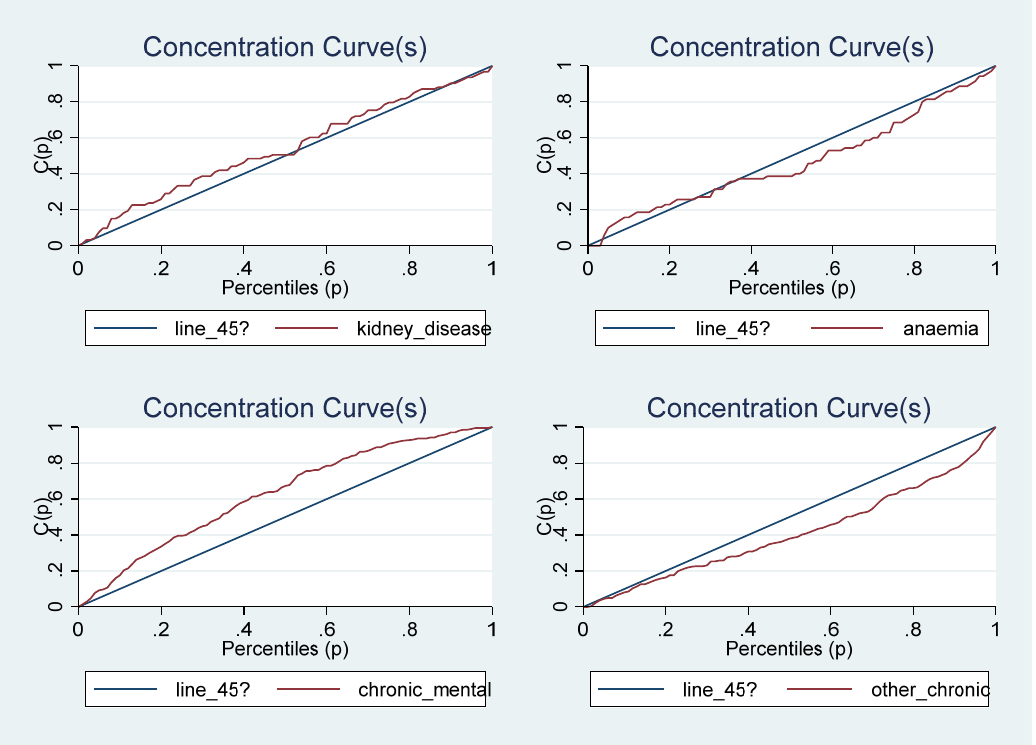
Figure 4. The Concentration Curves for some tobacco/alcohol ‐ related chronic diseases. The concentration curve is important in illustrating socioeconomic inequality at each point in the income distribution for the health outcomes of interest, but it cannot be used to quantify the magnitude of such socioeconomic inequality [51,52]. It is impossible to